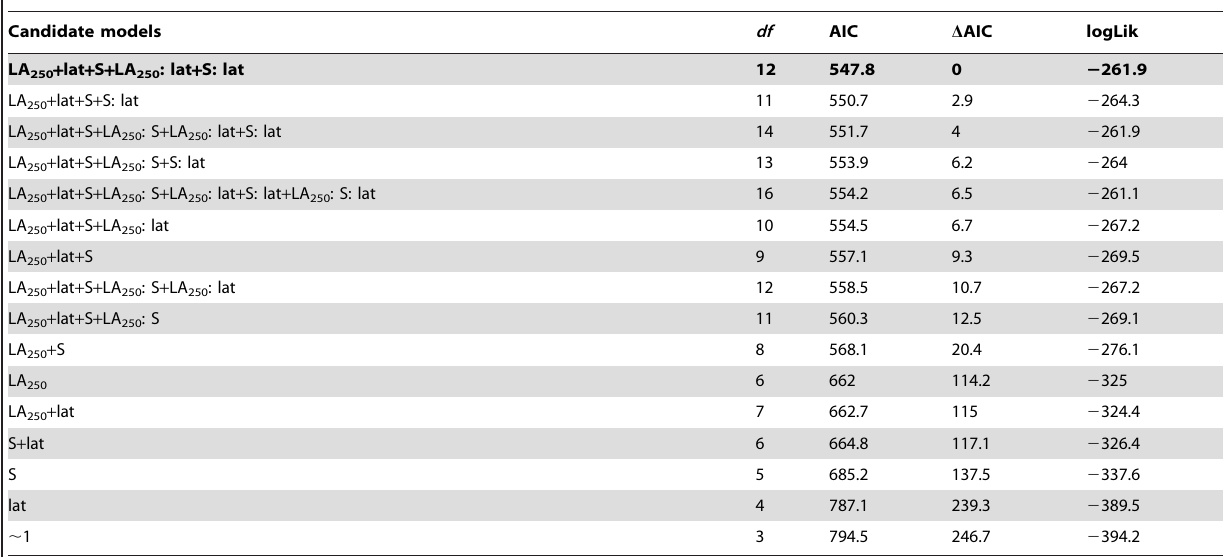
Table 4. Ranked mixed models.